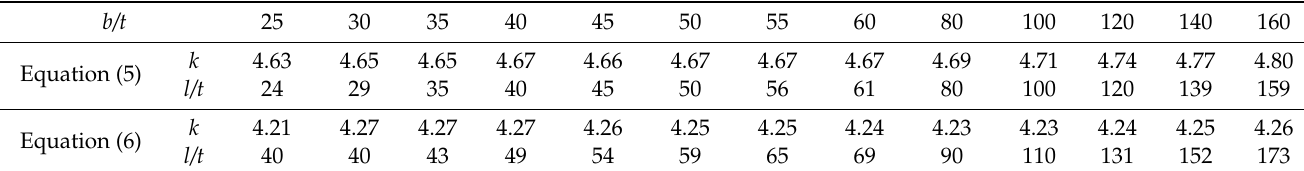
Table 5. Values of k and l/t for